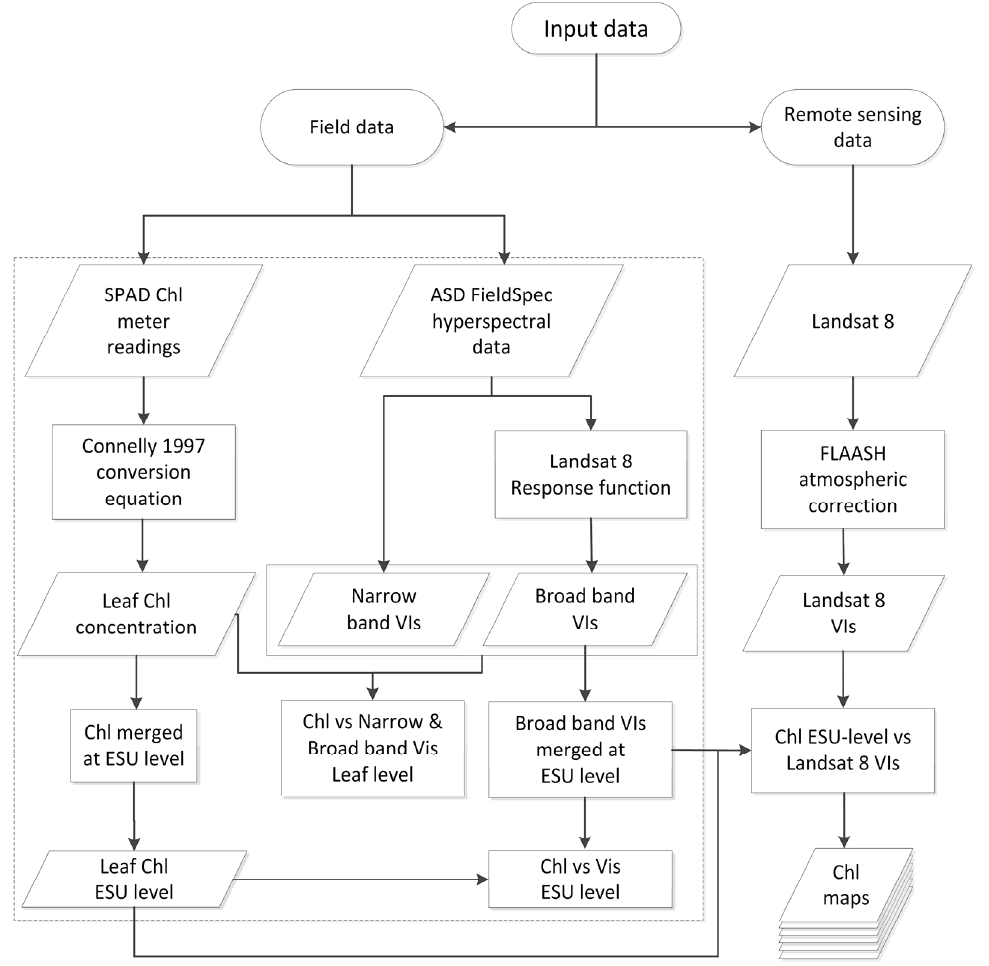
Figure 2. Schematic diagram of the procedures in relating CC to VIs. In this paper the leaf level refers to the CC and hyperspectral response measured at individual leaves. ESU level refers to CC and hyperspectral response averaged at Elementary Sampling Unit level (a plot of 30 m by 30 m to represent the spatial resolution of Landsat 8). Chl maps were computed using the Landsat 8 VI, which had the best performance in terms of correlation with Chl at ESU